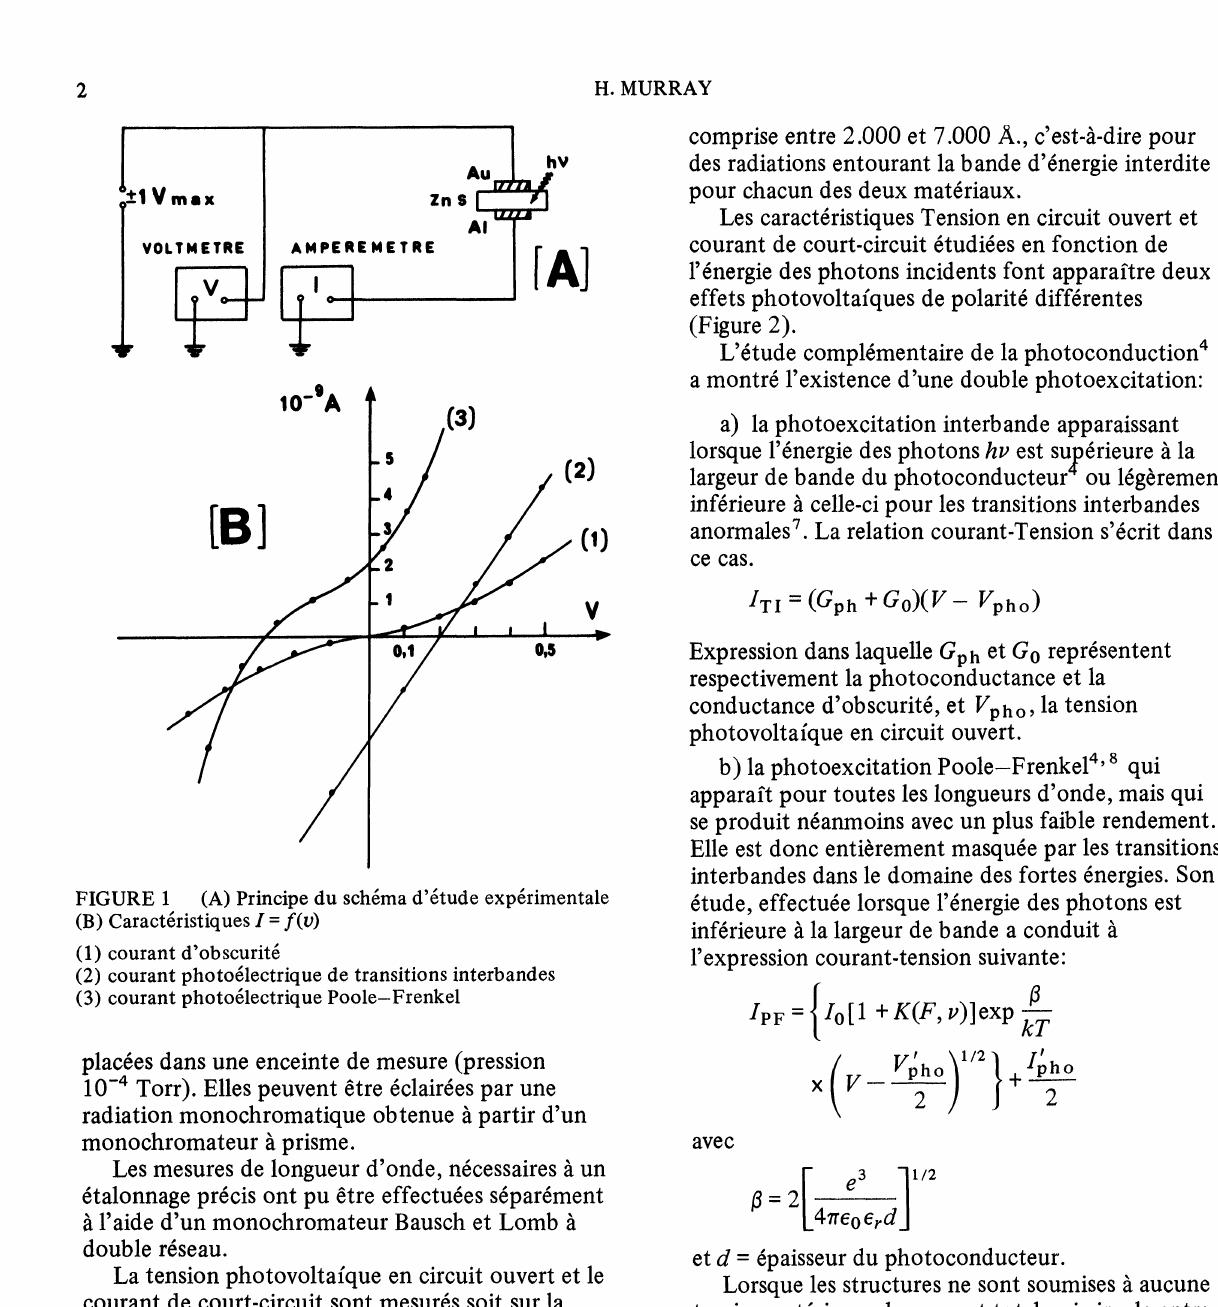
FIGURE (A) Principe du schema d’6tude exp6rimentale (B) Caractristiques 1 f(v) (1) courant d’obscurit6 (2) courant photo61ectrique de transitions interbandes (3) courant photo61ectrique Poole-Frenkel plac6es dans une enceinte de mesure (pression 10 -4 Torr). Elles peuvent 6tre 6clair6es par une radiation monochromatique obtenue partir d’un monochromateur h